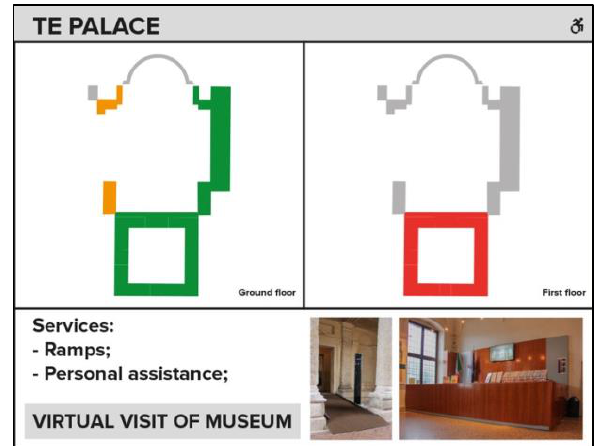
Figure 10. Graphic simulation of a possible pop-up window reachable from the map, after setting the physical impairments user profile, that could provide accessibility information about a specific POIs © Sebastiano Marconcini,